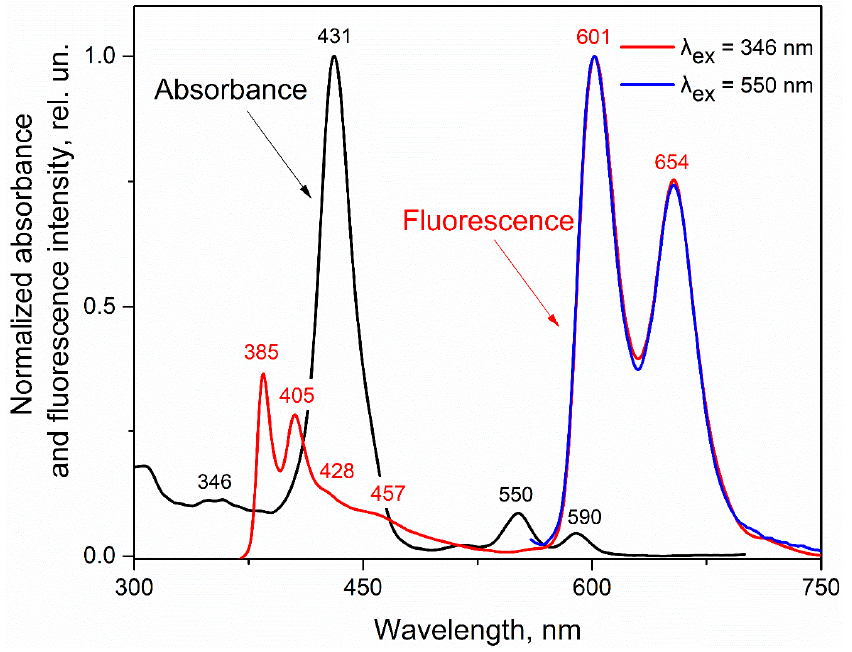
Figure 2. The normalized by maximum UV-vis absorbance and fluorescence spectra of ZnPIP in